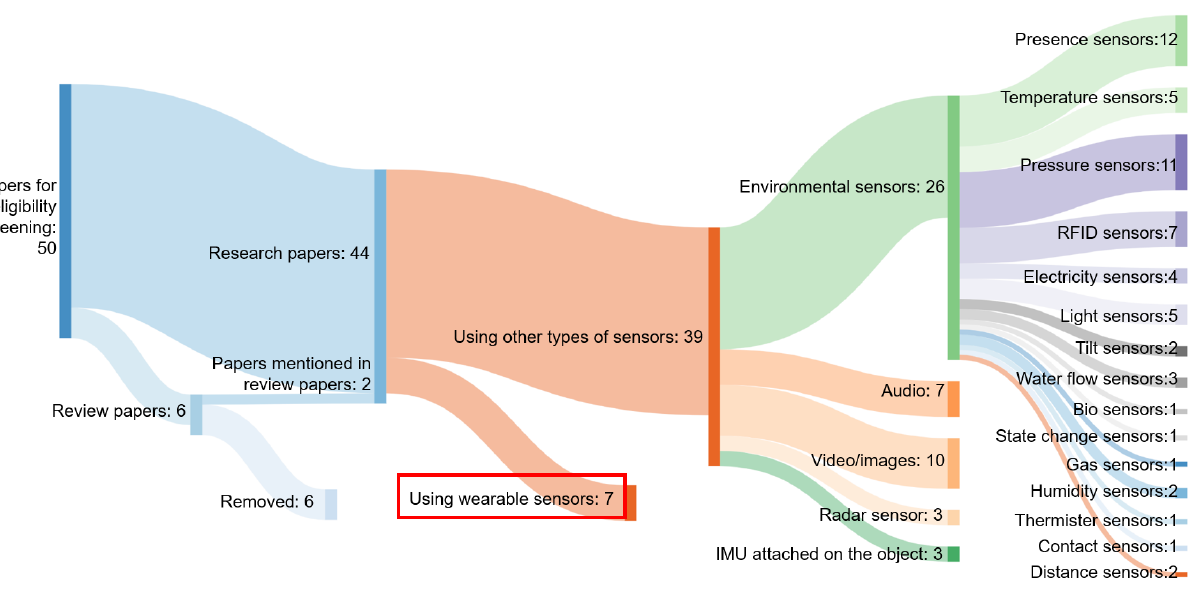
Figure 2. Sankey Diagram of the overview of the papers for eligibility